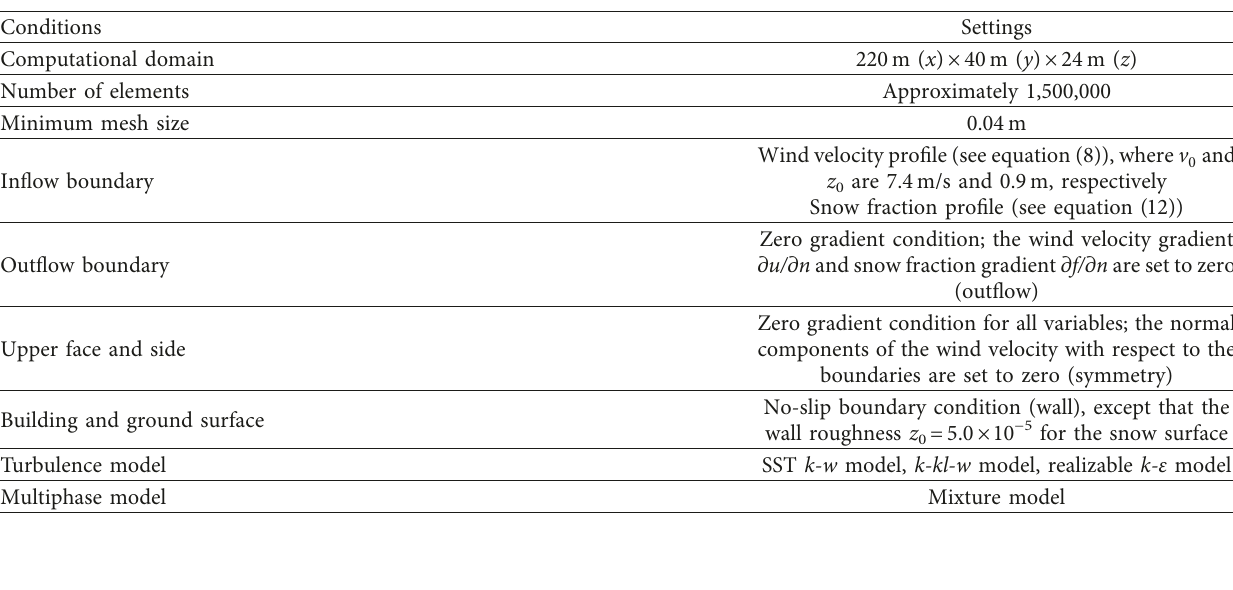
Figure 2: Sketch of model [2]. Table 1: Computation